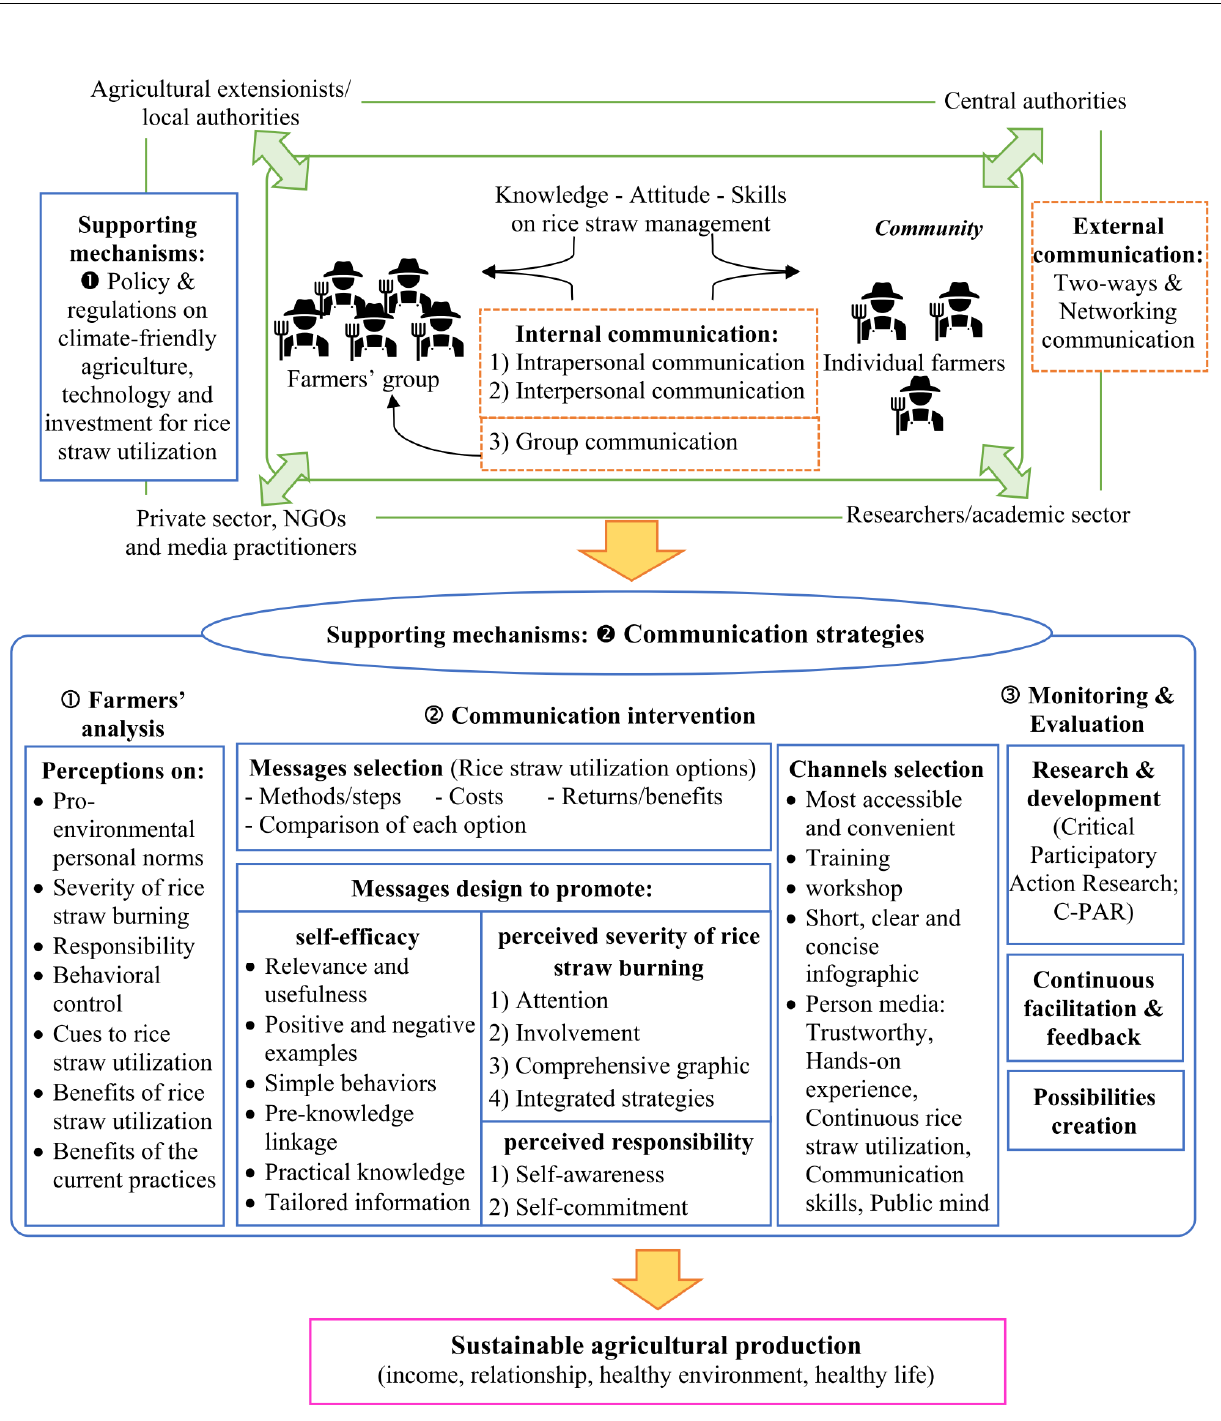
Figure 3. Communication strategies for promoting non-burning rice straw and stubble management to achieve social-ecological benefits for more sustainable agricultural production.